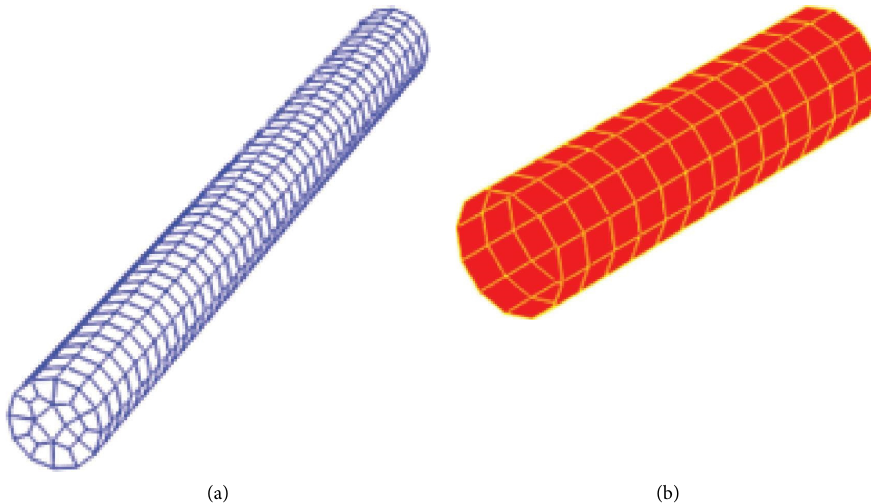
Figure 10: Meshing of steel elements in the proposed EF model. (a) Steel bar element. (b) Steel ring contact